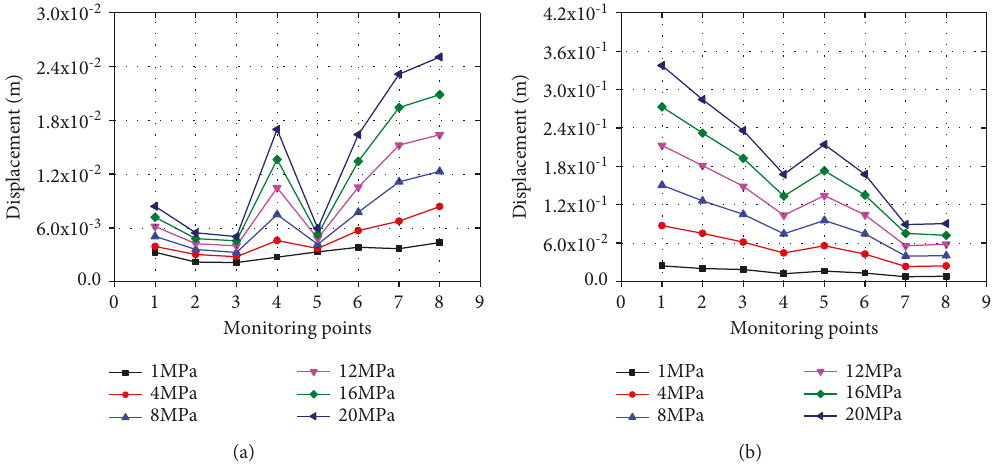
Figure 10: Surrounding rock displacements of the roadway at different monitoring points. (a) Horizontal displacement. (b) Vertical